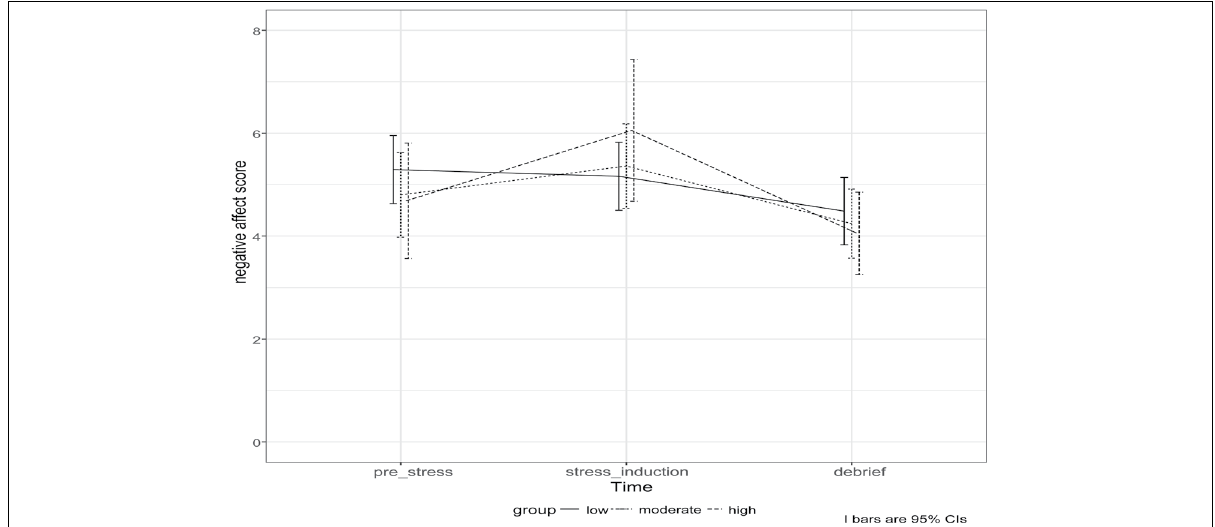
Figure 4: Time x group interaction of total negative affect scores from the PANAS, Experiment Table 2: Means and standard deviations for recall type by condition MAST Placebo ANCOVAs M SD M SD F p d Location details